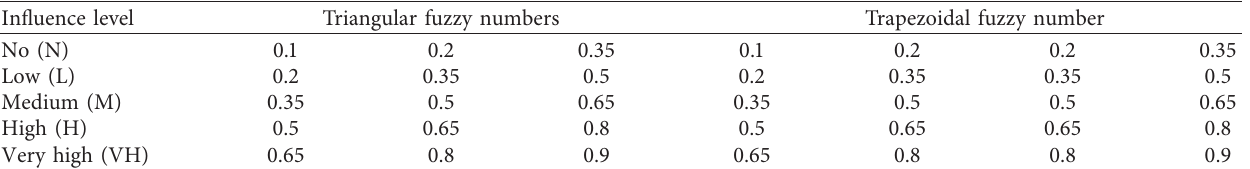
Table 19: Linguistic variables for triangular and trapezoidal fuzzy numbers.